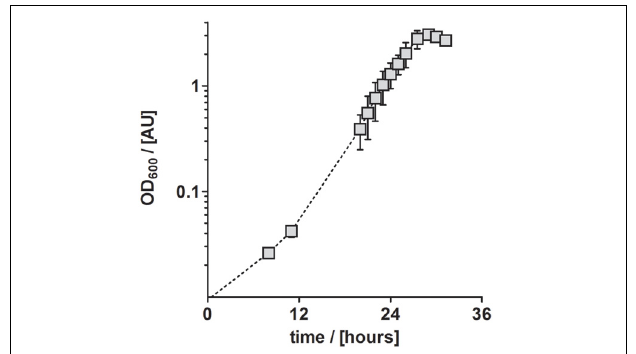
FIGURE 5 | Dependence of anaerobic growth rates of P. denitrificans Pd1222 on temperature. The growth rates were determined from the early exponential growth phases of duplicate or triplicate growth curve measurements on the improved medium, supplemented with trace element solution TE-3-Zn ( Table 2 , series 5). Error bars indicate standard deviation and may be smaller than the symbols.